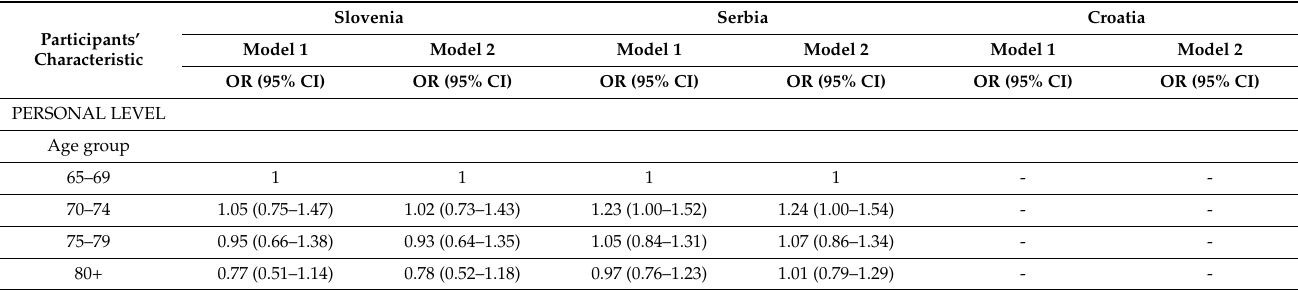
Table 6. Multivariate logistic regression models with likelihood financial burden of medical care among the older-aged population in Slovenia, Serbia, and Croatia as an outcome